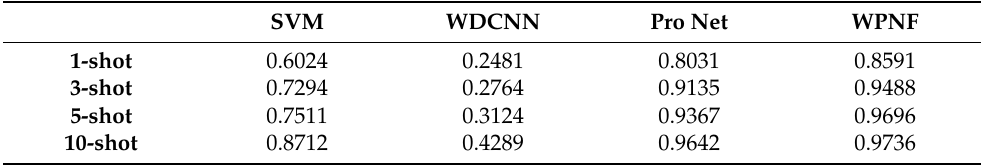
Figure 8. Flow chart of the experiment: ( a ) Deep Convolutional Neural Networks with Wide First-layer Kernels (WDCNN); ( b ) Pro Net; ( c ) The proposed method (the wavelet-prototypical network based on fusion of time and frequency domain WPNF); ( d ) Support Vector Machine (SVM). Table 2. Comparison of accuracy of models.